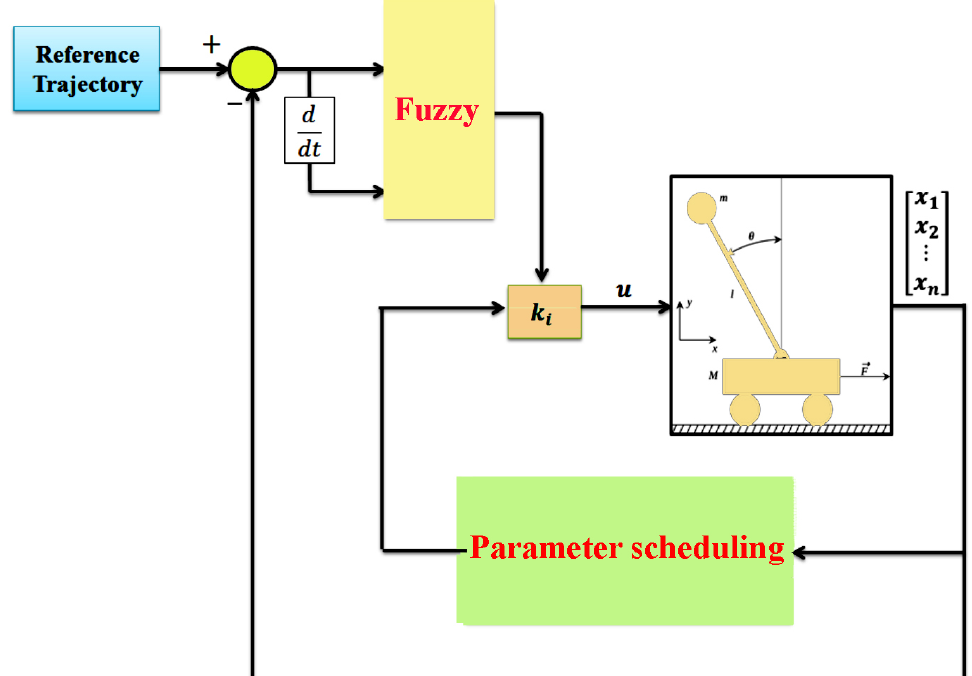
Figure 2. Structure of the proposed control system.